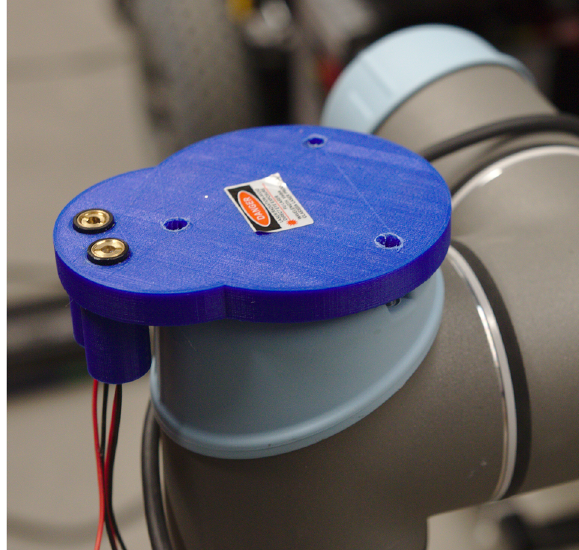
Figure 8: Joystick and panel of buttons used to control TUI.